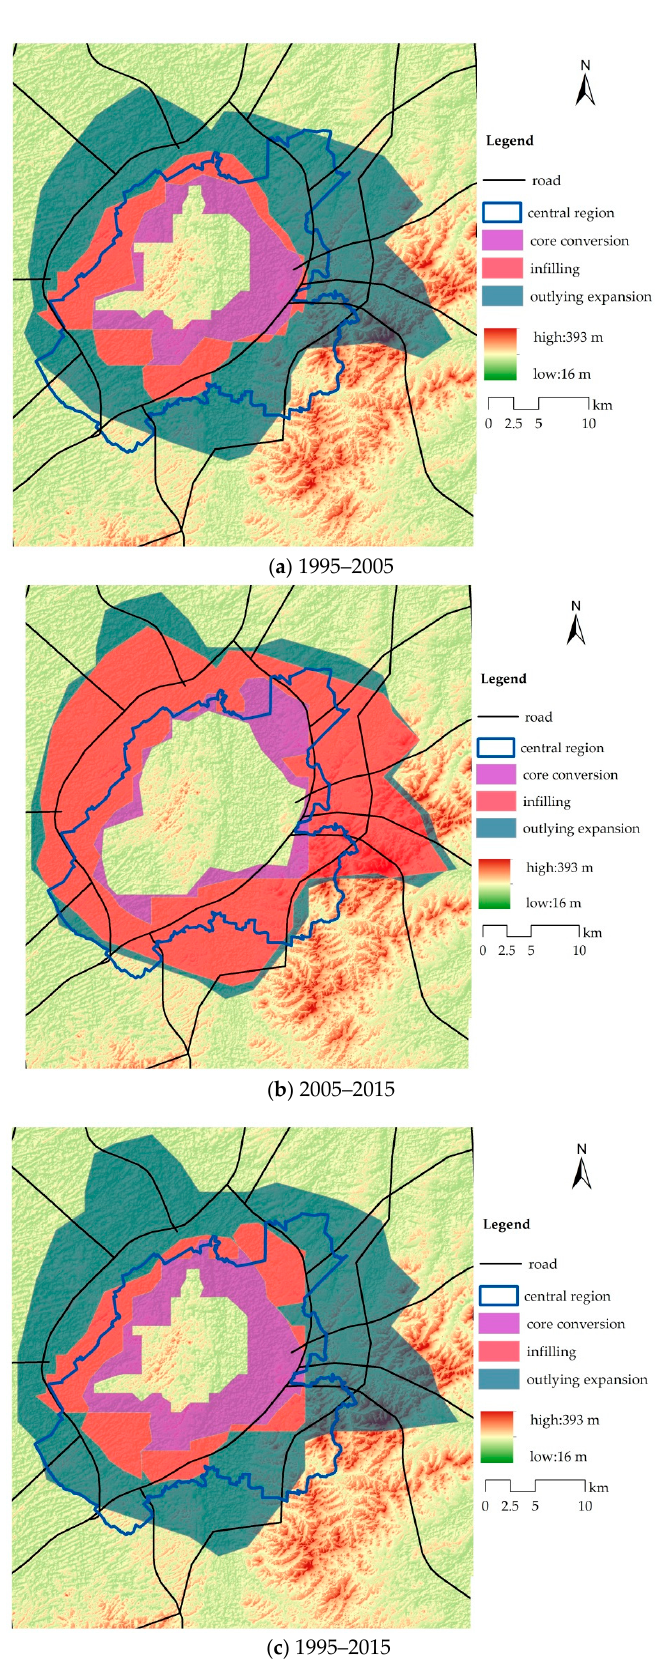
Figure 10. ( a – c ) Distribution of change types in the urban fringe of Changchun (1995–2015).